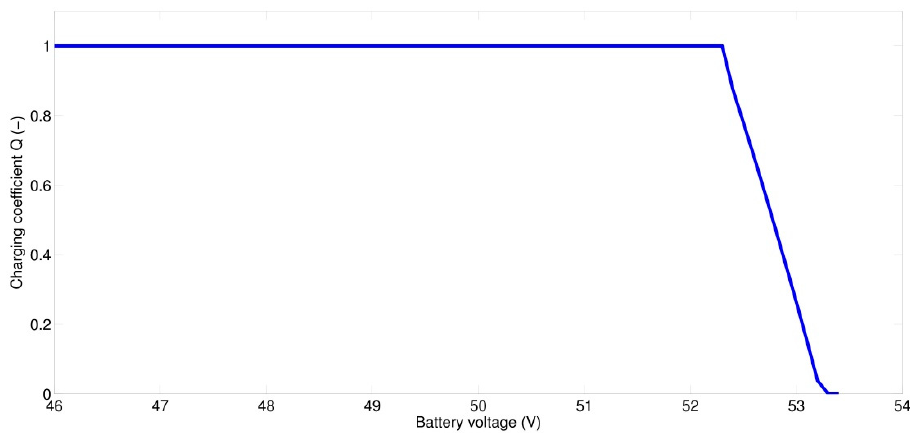
Figure 7. Dependence of control coefficient on instantaneous battery voltage.